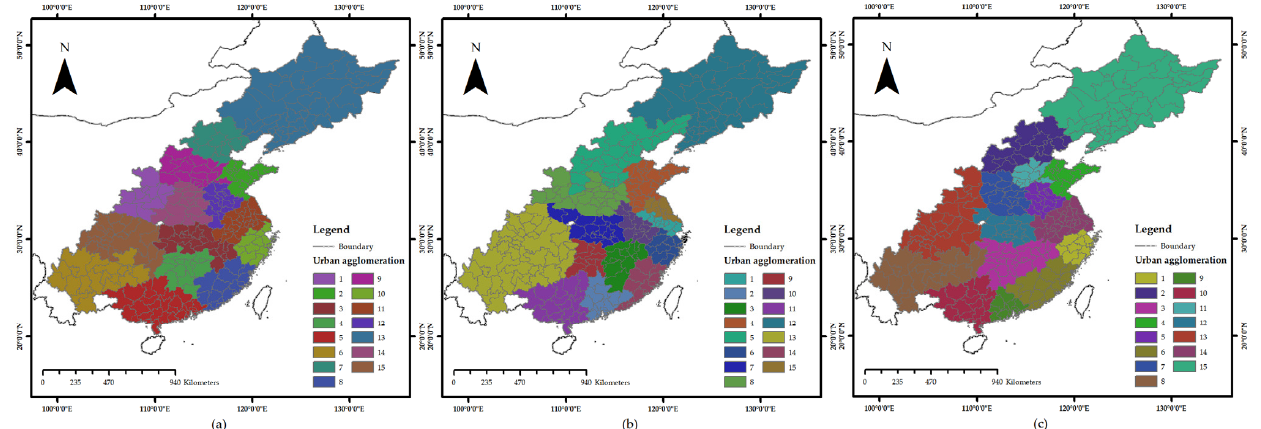
Figure 11. The urban agglomeration identification results. ( a ) Nighttime light urban network; ( b ) Railway urban network; ( c ) Composite urban network.